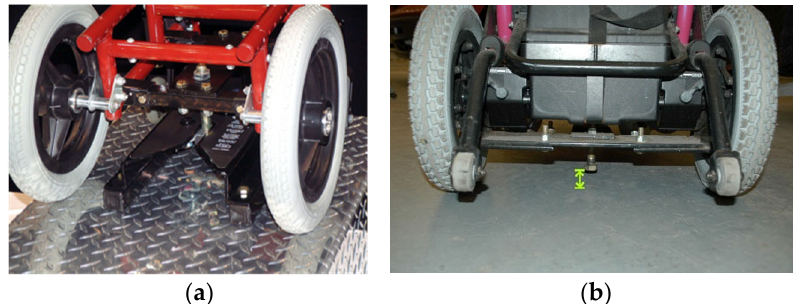
Figure 1. Examples of wheelchair engaged with docking system mounted to vehicle floor ( a , b ) and an example of mating hardware with low ground clearance ( b ).